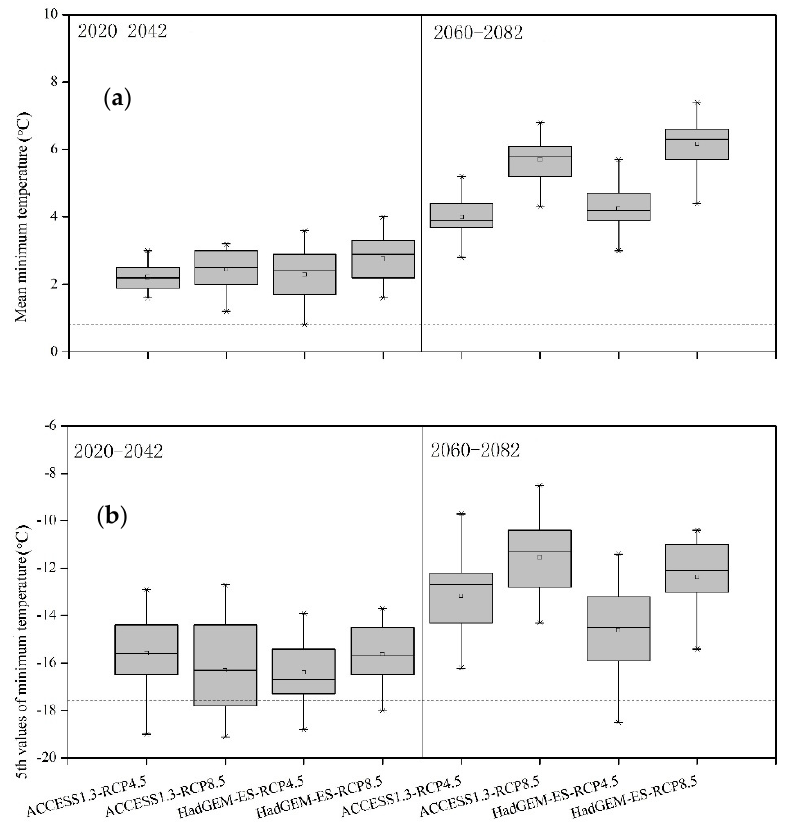
Figure 5. ( a ) Projected mean and ( b ) 5th values of minimum temperature under the different combinations of GCMs and RCPs scenarios during the different assessment periods.